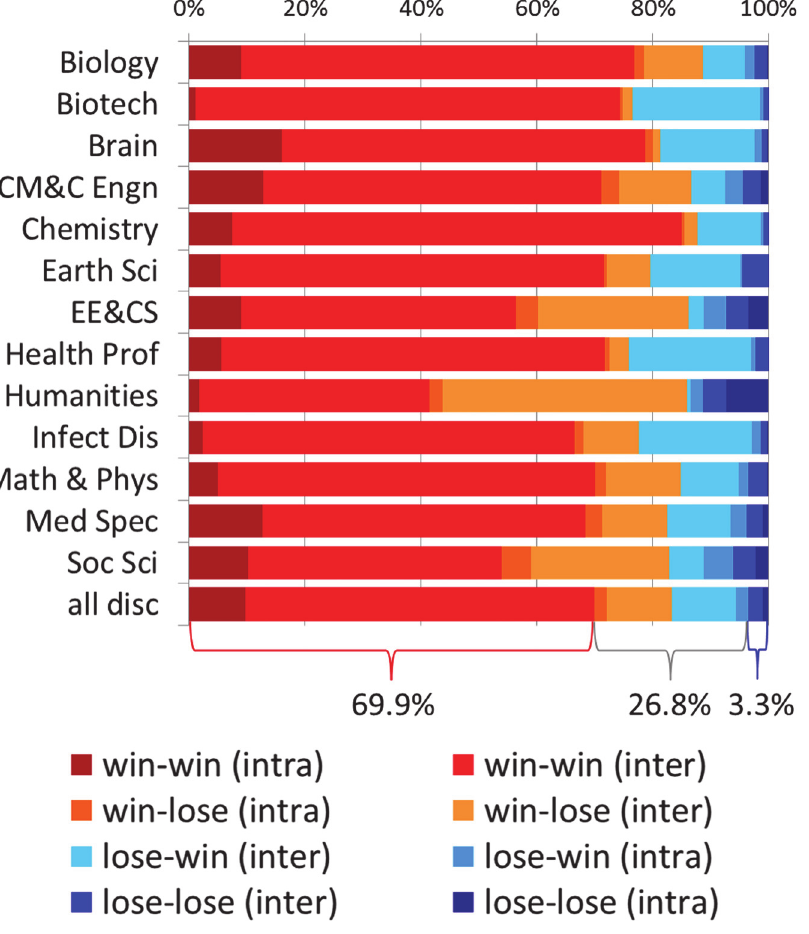
Fig 2. Percentages of inter- and intradisciplinary win-win, win-lose, lose-win and lose-lose relationships of subdiscipline pairs.